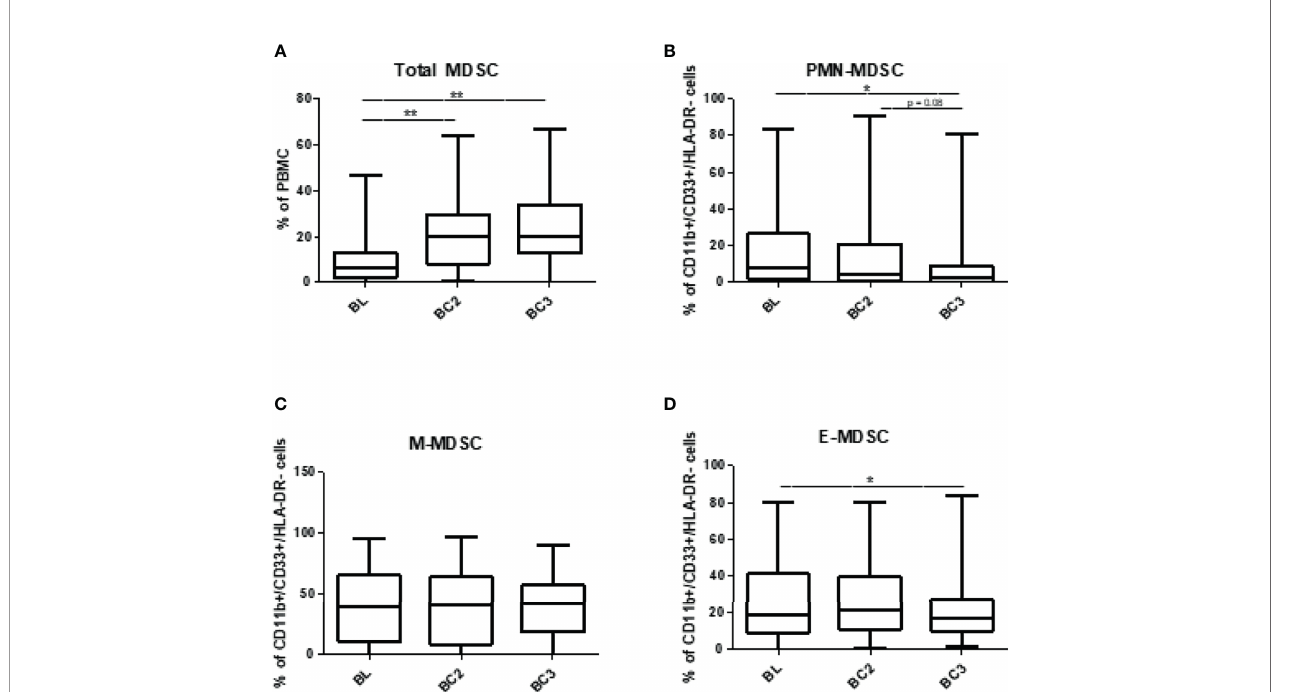
FIGURE 2 | Levels of circulating myeloid-derived suppressor cells over the course of immune checkpoint blockade. Patient PBMCs were isolated at the time of initiation of immune checkpoint therapy (baseline, BL), and prior to the beginning of cycles 2 (before cycle 2, BC2) and 3 (before cycle 3, BC3) and analyzed for total MDSC (CD11b + , CD33 + , HLA-DR lo/- ) and granulocytic (CD15 + ), monocytic (CD14 + ), or early (CD14-/CD15-) subsets via fl ow cytometry. (A) Total MDSC are represented as a percentage of PBMC, and individual subsets represent the proportion of MDSC that fall into each subset: (B) PMN-MDSC, (C) M-MDSC, and (D) E-MDSC Data are shown as box and whisker plots with ranges, *p < 0.05, **p <